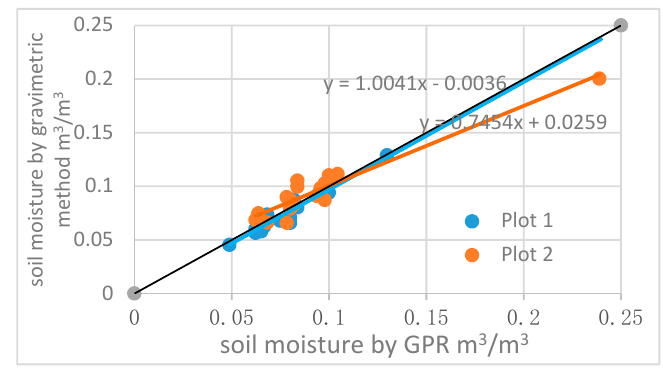
Figure 9. Comparison of the soil moisture measured by GPR and gravimetric method in Plot 1 and Plot 2.